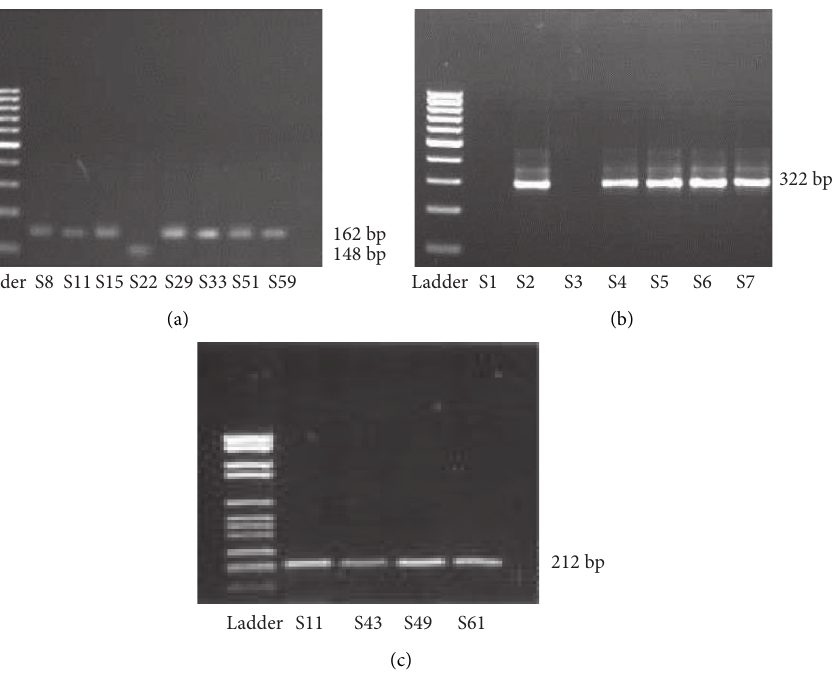
Figure 4: Selected agarose gel images of PCR-RFLP products of Pfdhfr wild and mutant alleles: (a) codon C59R with 162 bp indicating mutant allele; (b) codon S108N with 322 bp indicating wild allele; (c) codon N51I with 212 bp indicating mutant allele. S: sample. Lad: ladder.